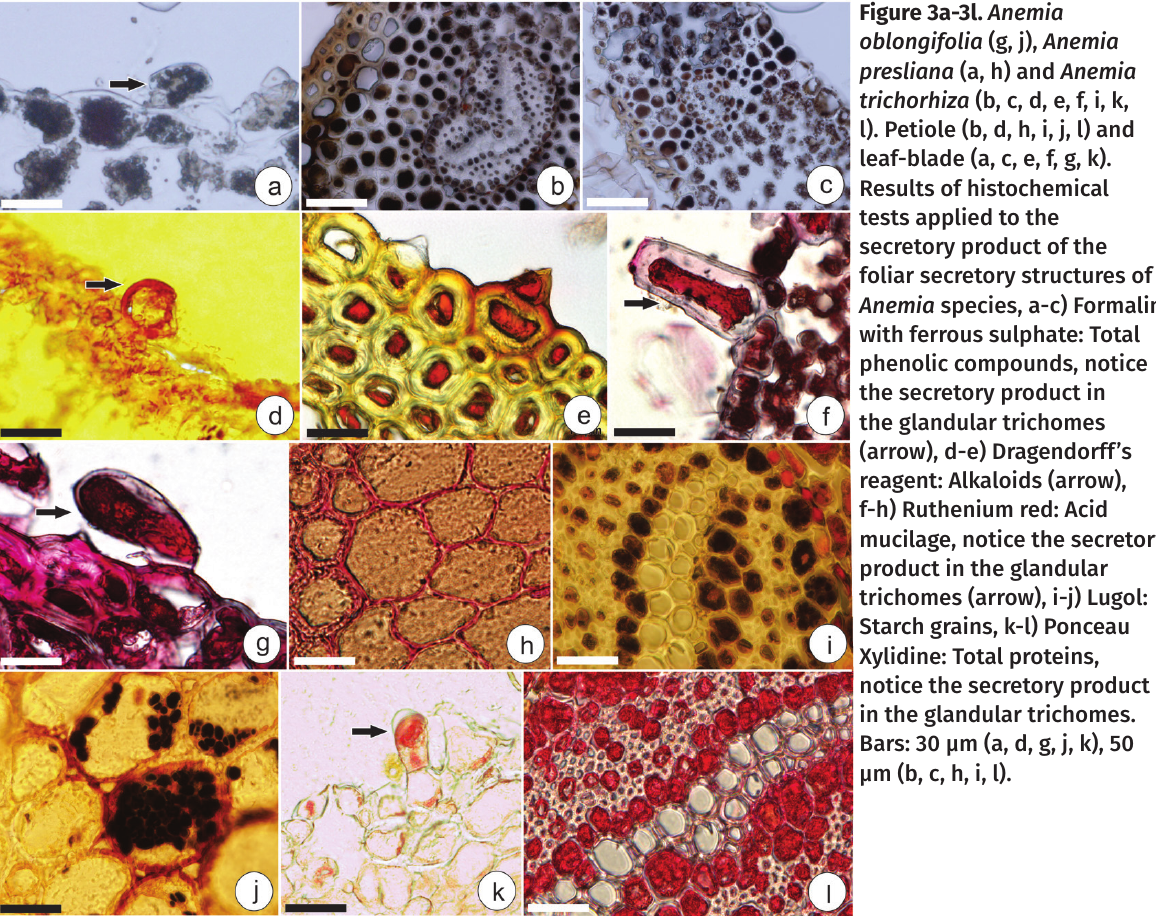
Figure 3a-3l. Anemia oblongifolia (g, j), Anemia presliana (a, h) and Anemia trichorhiza (b, c, d, e, f, i, k, l). Petiole (b, d, h, i, j, l) and leaf-blade (a, c, e, f, g,